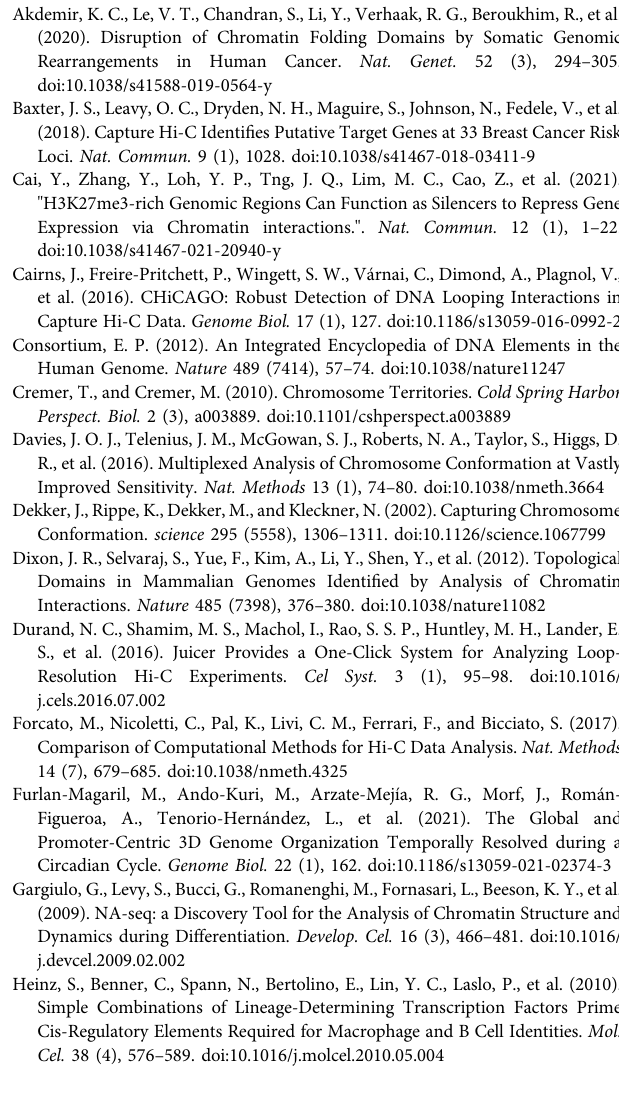
Supplementary Table S8 | Percentage of regulatory interactions that overlap in at least two replicates for each bait. DHS: DNase I Hypersensitivity sites. Supplementary Table S9 | Percentage of regulatory interactions, where both ends have been extended by 2.5 kb that overlap in at least two replicates for each bait. DHS: DNase I Hypersensitivity sites. Supplementary Table S10 | Percentage of regulatory interactions, where both ends have been extended by 20 kb that overlap in at least two replicates for each bait. DHS: DNase I Hypersensitivity